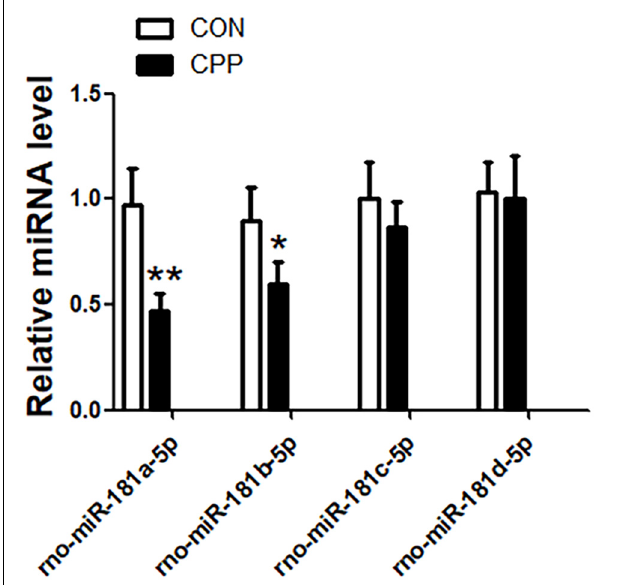
FIGURE 1 | The expression of miR-181a-5p and miR-181b-5p were downregulated in the dorsal striatum of METH-induced CPP rats group, but the expression of miR-181c-5p and miR-181d-5p were not changed. mRNA was determined by qRT-PCR, and the values were normalized to the geometric mean of a control gene U6. Data represent the mean ± SD, n = 8 in each group. * P < 0.05 and ** P < 0.01 compared with control group, two tailed Student’s t